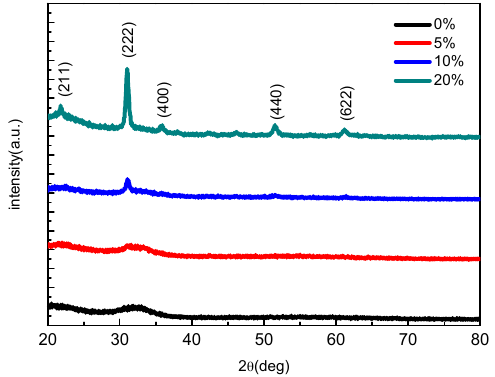
Figure 2. X-ray diffraction (XRD) patterns of the indium–gallium–oxide (IGO) films with different oxygen partial pressure by radiofrequency (RF) magnetron sputtering.